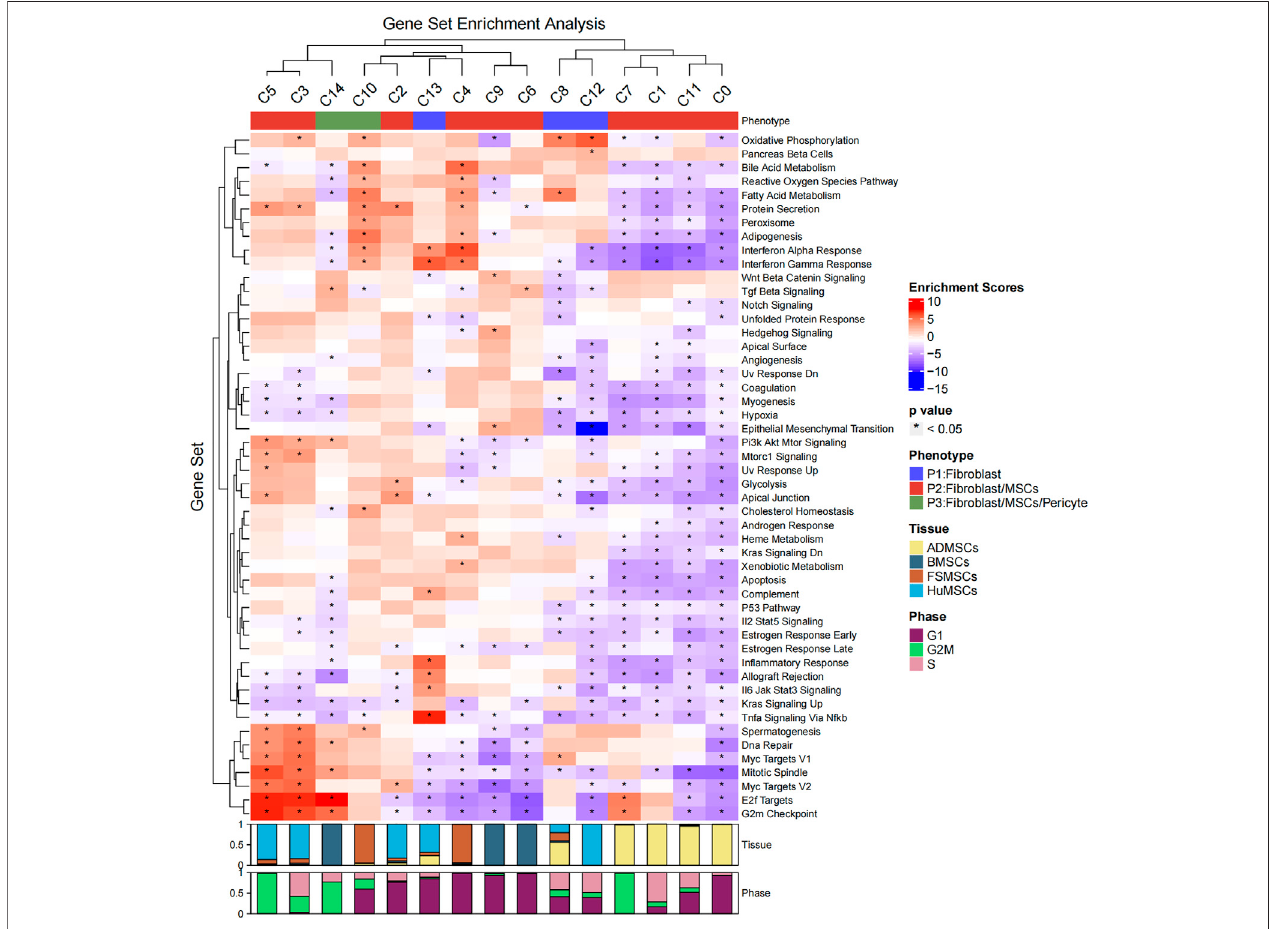
FIGURE 2 | Hallmark gene set enrichment analysis of the 15 cell subsets. The heatmap plot shows the enrichment scores and p -values of different hallmark gene sets among the 15 different cellular subsets. The color of the grids denotes the enrichment scores of the gene set, with red representing high enrichment and blue representing low enrichment. The bar graphs (top) represent different molecular phenotypes ( fi broblasts, MSCs, and/or pericytes) represented by the 15 different cell subsets and is shown with different colors. The asterisk indicates that the p -value was less than 0.05. The bar charts (below) represent the cell cycle phases of different proportions of cells in the 15 cell